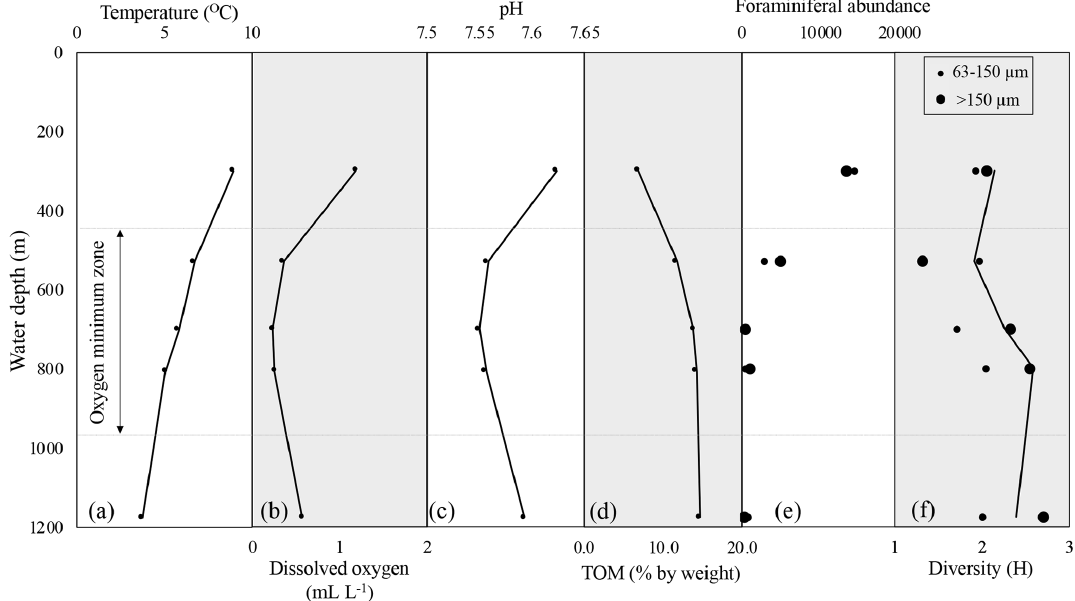
Figure 2. Profiles of temperature (a) , dissolved oxygen (b) , pH (c) , and total organic matter (% by weight) (d) across the depth transect. Foraminiferal abundance (total calcareous foraminifera) (e) and diversity (Shannon index, H ) (f) are shown for two size fractions. In panels (e) and (f) , large black dots are > 150µm size fraction, small black dots are 63–150µm size fraction, and the black line on the diversity plot represents trends from the complete assemblage ( > 63µm). Assemblage counts are standardized to the volume (63.62cm 3 ) of the sampled cylinder of the sediment (core). Dashed gray line shows approximate boundaries of the oxygen minimum